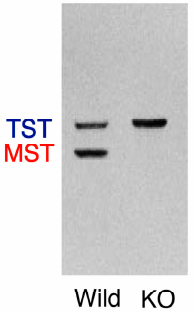
Figure 4. Western blot analysis of mitochondrial fractions for TST and MST. The band representing TST molecules from KO mice is more prominent than that of wild-type mice in the mitochondrial fractions.